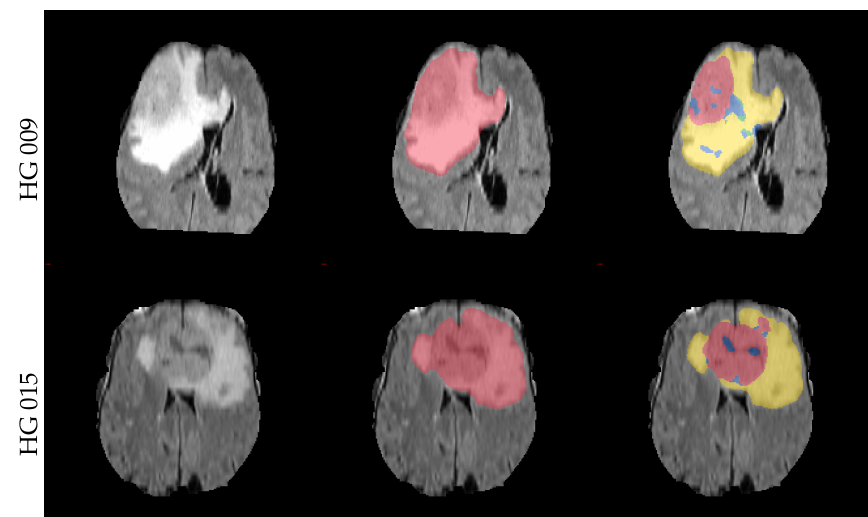
Figure 7. Example axial and coronal (HG 006) slices from the validation set u(BraTS 2013 dataset) using the proposed PU-learning method. The colour coding is as follows: ‘yellow’: edema; ‘red’: enhancing tumour; ‘green’: non-enhancing tumour; ‘blue’: necrosis. The subject name is identical to the identifier within the original training